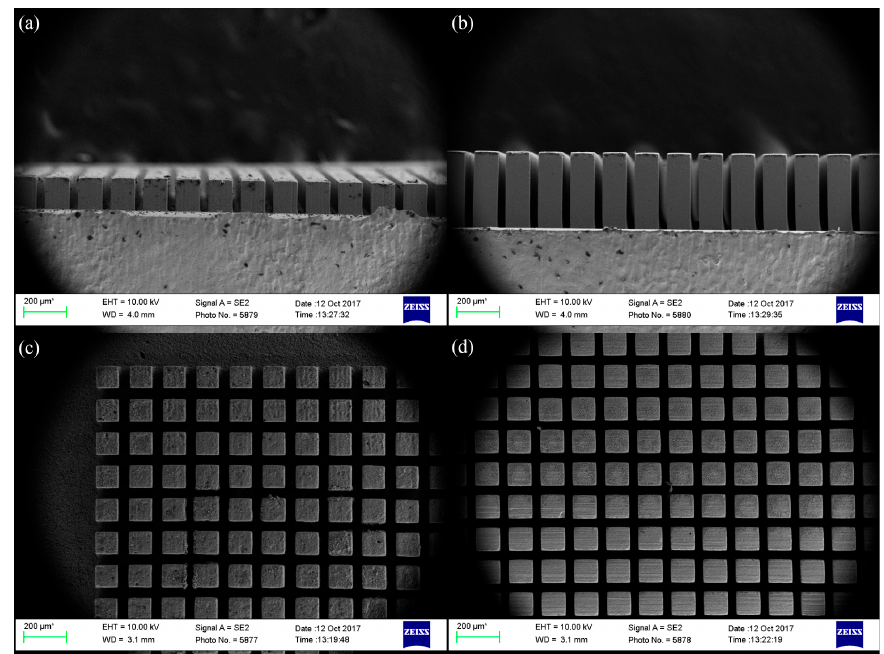
Figure 7. SEM images of sintered micro-patterns: ( a ) side view of the short micro-pattern; ( b ) side view of the tall micro-pattern; ( c ) top view of the short micro-pattern; and ( d ) top view of the tall micro-pattern.